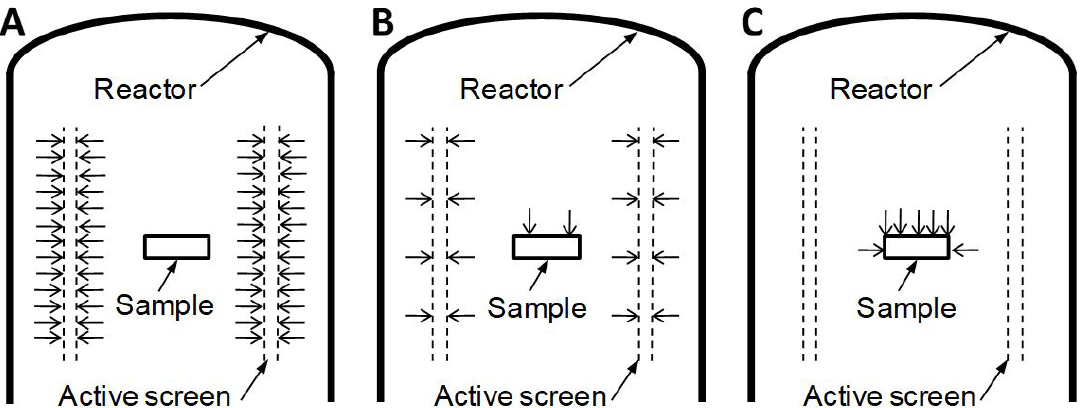
Figure 3. Electromagnetic fields of biased processes. (A) the maximum voltage on the active screen. (B) voltages of the same intensity. (C) the maximum voltage in the